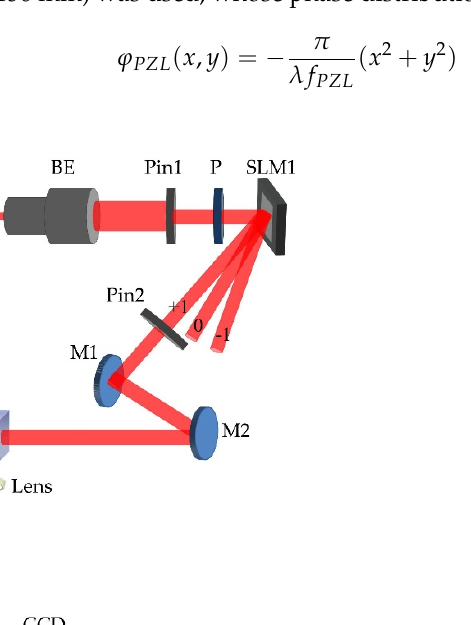
Figure 4. ( a ) The intensity and ( b ) phase distribution of the numerically simulated composite OAM beam; ( c ) target image containing signal and noise domain; ( d ) CGH of the target image ( c ); ( e ) RMSE; and ( f ) PSNR.